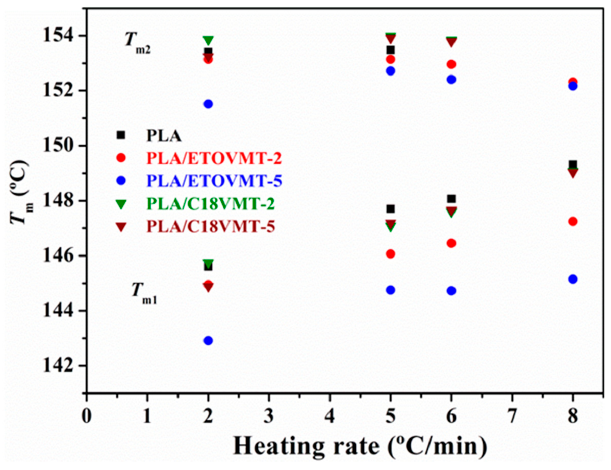
Figure 4. Melting temperatures of PLA and PLA / VMT nanocomposites as a function of the heating rate.